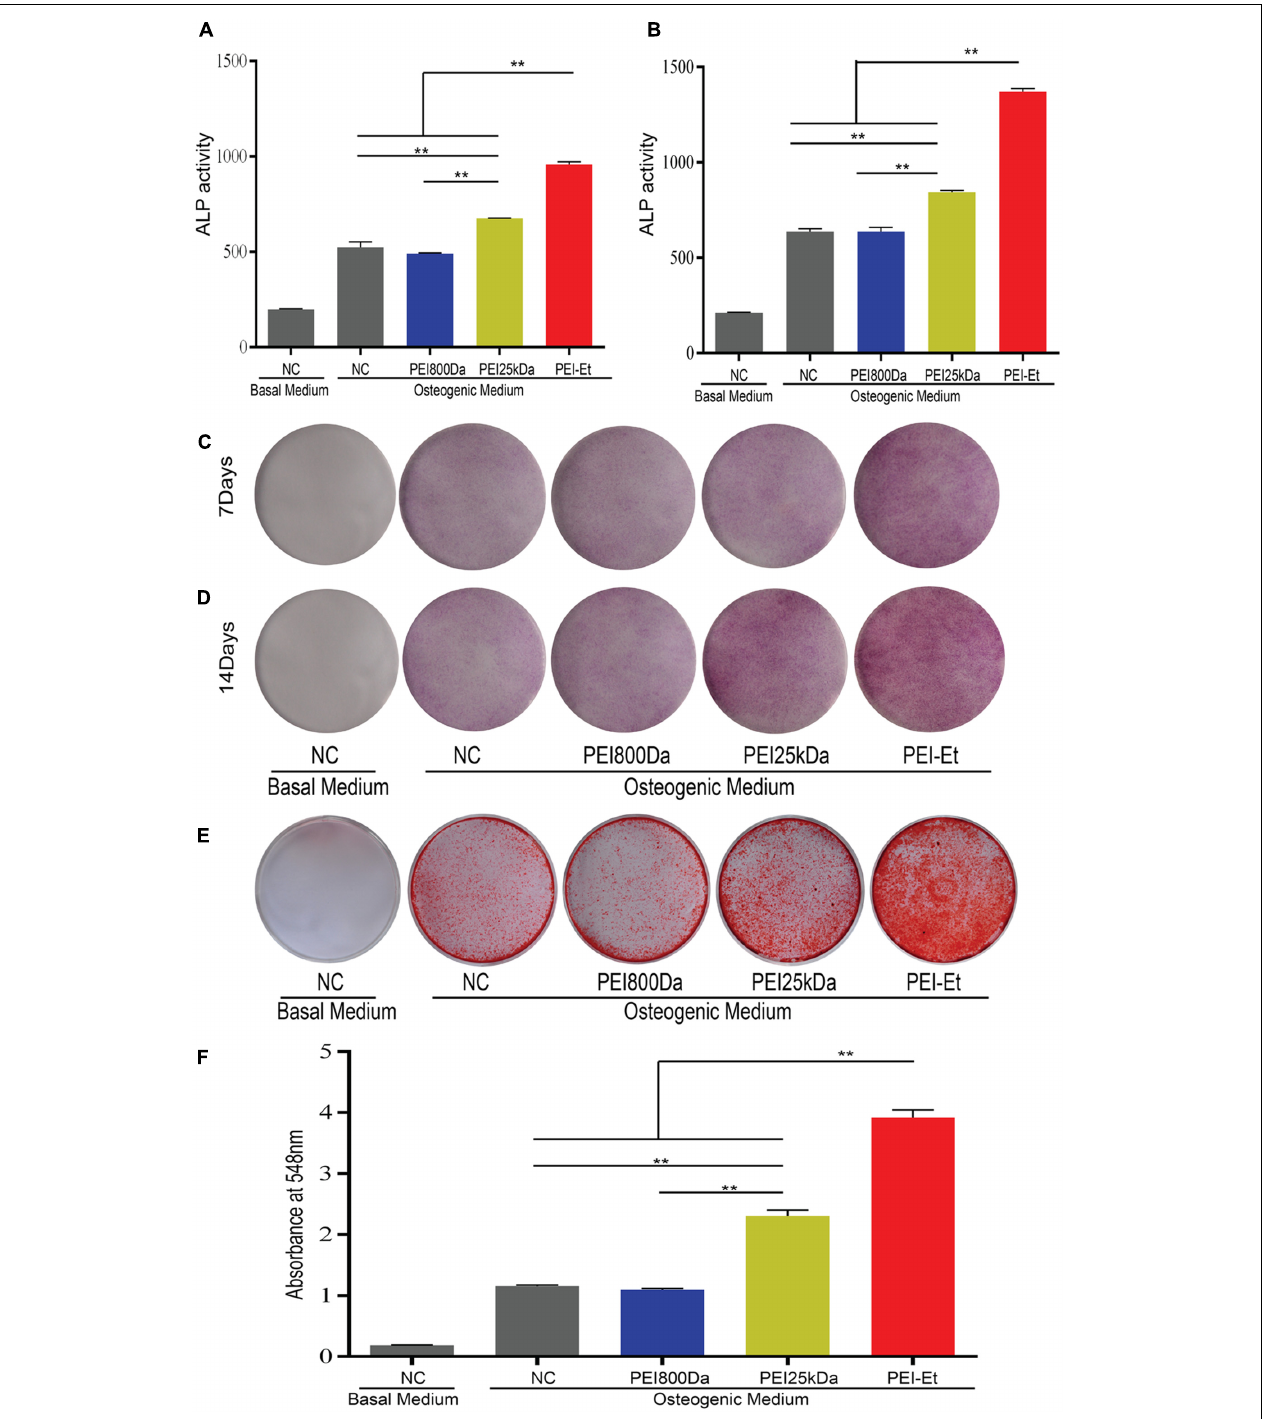
FIGURE 6 | Chordin knockdown improving the osteogenic capacity of hBMSCs. ALP activity measured at 7 (A) and 14 (B) days after transfection with different polyplexes. ALP staining measured at 7 (C) and 14 (D) days after transfection with different polyplexes. (E) Alizarin red S staining measured after 21 days of osteogenic induction. (F) Quantitative analysis of alizarin red S staining. Representative images of three independent experiments were shown. Data are presented as the means ± SD of three independent experiments, N = 3. ∗∗ P < 0.01.